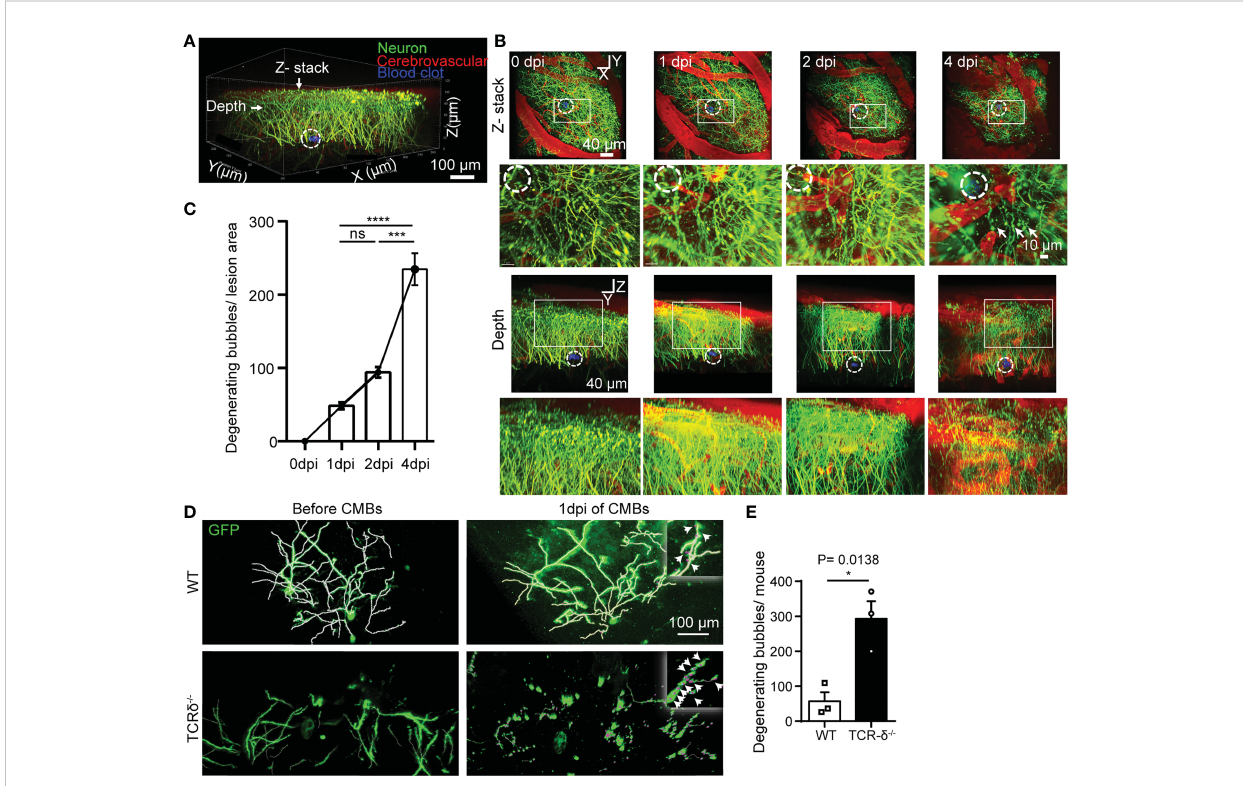
FIGURE 6 gd T cells de fi ciency accelerates CMBs-induced neuron degeneration. (A – C) In vivo imaging of pyramidal neurons surrounding the injury site (dotted circles) at different timepoints after CMBs using Thy1-YFP mice. From lateral and vertical view, reconstruction of stacked sections (B) and statistical analysis (C) shows abundant degenerating neurite bubbles at 4 dpi, but very rare before 4 dpi (blood vessels labelled by rhodamine in red; enlarger images in B from rectangular frames upper respectively; *** P <0.001, **** P <0.00001; One-way ANOVA with Tukey ’ s multiple comparison; n=3 mice in each group). (D, E) Spare neurons in the cortex are labelled using AAV9-CMV-GFP virus in WT and TCR- d -/- mice. Neurites are well de fi ned with no degenerating bubbles before CMBs in both groups. Many degenerating neurite bubbles are visible in the TCR- d -/- at 1 dpi of CMBs, but a few in the WT (D) ; arrows in the insets). Statistics shows a signi fi cant increase of degenerating neurite bubbles in the mutant ( E ; * P <0.05; Student ’ s t -test; n=3 mice in each